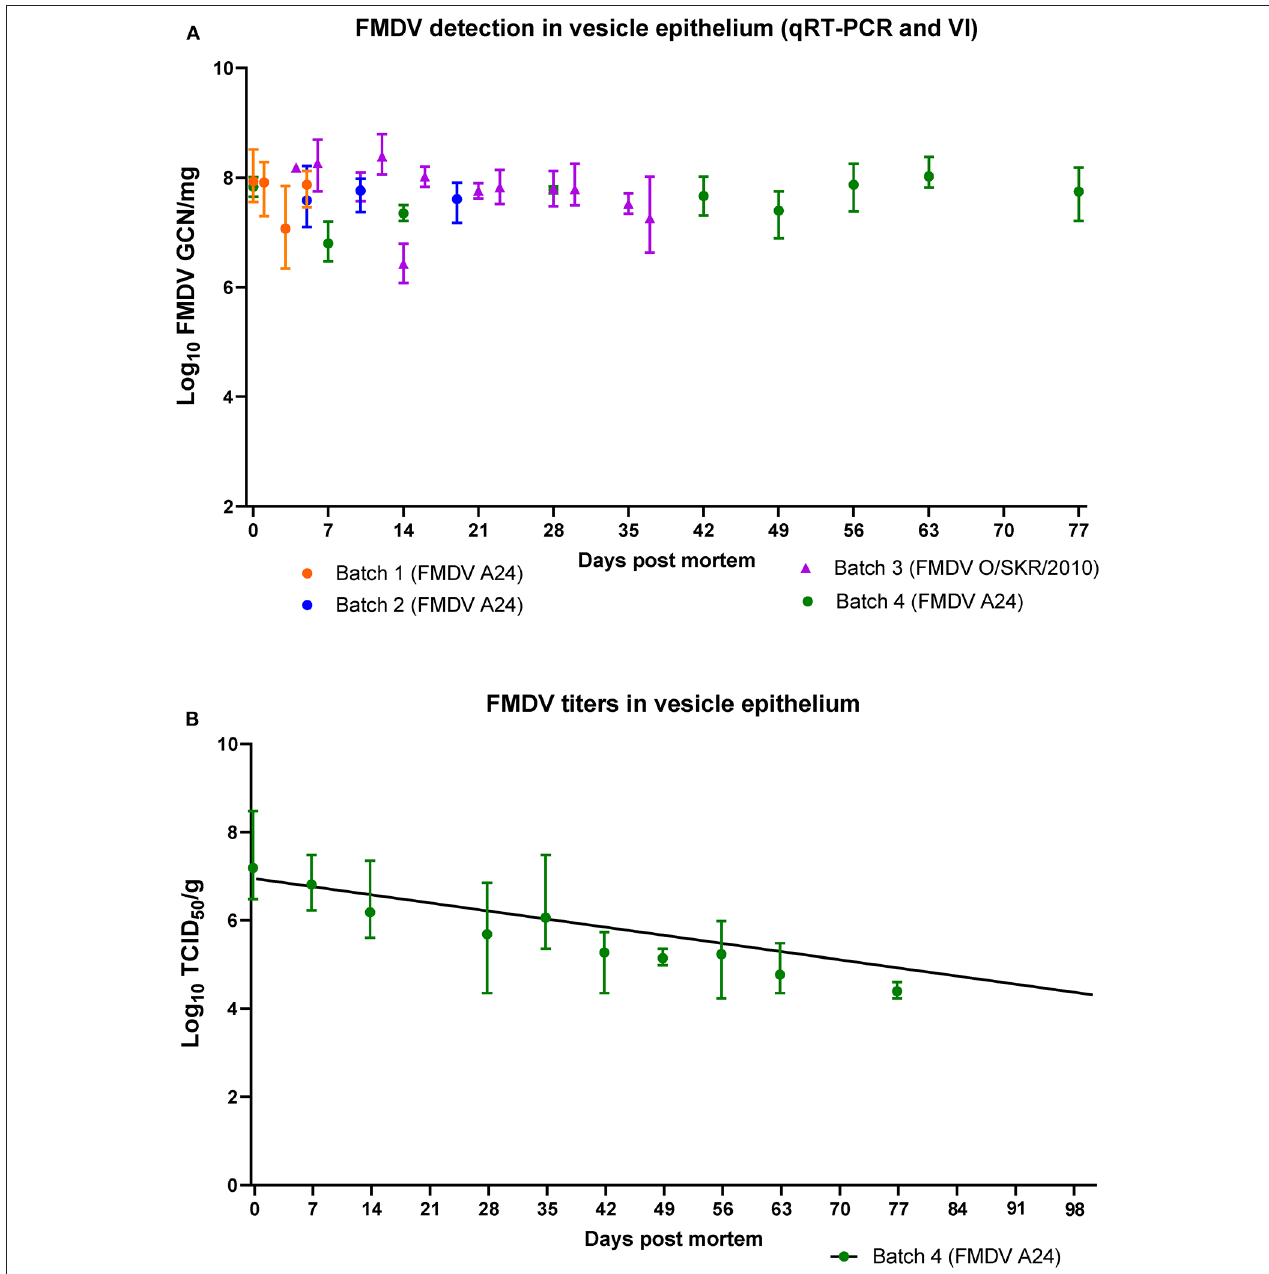
FIGURE 4 | FMDV detection in vesicle epithelium of pig carcasses. (A) FMDV quantities (log 10 GCN/mg) in samples of vesicle epithelium obtained from 4 separate batches of pig carcasses infected with FMDV A24 Cruzeiro or FMDV O/SKR/2010 and stored at 4 o C from 0 to 77 days post mortem (dpm). All samples were positive by virus isolation. (B) FMDV titers (log10 TCID 50 /g) in vesicle epithelium obtained from 3 carcasses infected with FMDV A24 Cruzeiro from 0 to 77 dpm. All plotted values represent geometric means and range. The fitted line represents a simple linear regression with day as the independent variable and individual sample titers as the dependent variable (slope = − 0.034, half-life = 128